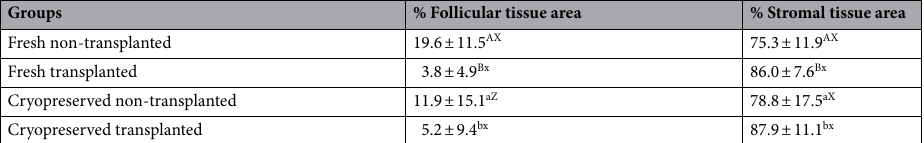
Table 2. Area of ovarian tissue occupied by stromal tissue and follicular tissue (mean percentage ± SD) in samples of fresh and cryopreserved ovarian tissue, before and after transplantation. Different letters indicate significant difference ( p < 0.05), in the same column, according to the following code: A,B Difference between Fresh non-transplanted and Fresh transplanted groups. a,b Difference between Cryopreserved non-transplanted and Cryopreserved transplanted groups. X,Z Difference between Fresh non-transplanted and Cryopreserved non-transplanted groups. x,z Difference between Fresh transplanted and Cryopreserved transplanted groups.